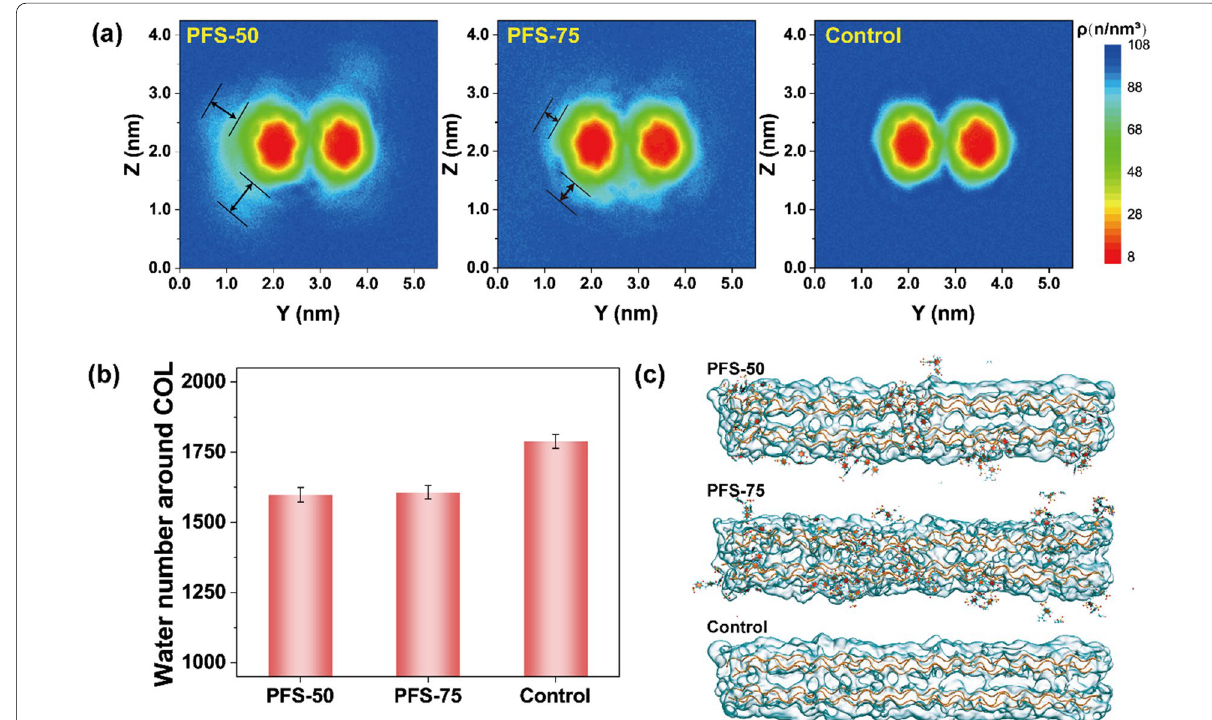
the retanned leathers (Fig. 3). Considering the fact that the fatliquoring and drying processes were the same, the water content increase of the crust leather should be mainly due to the decrease in DS of PFS.